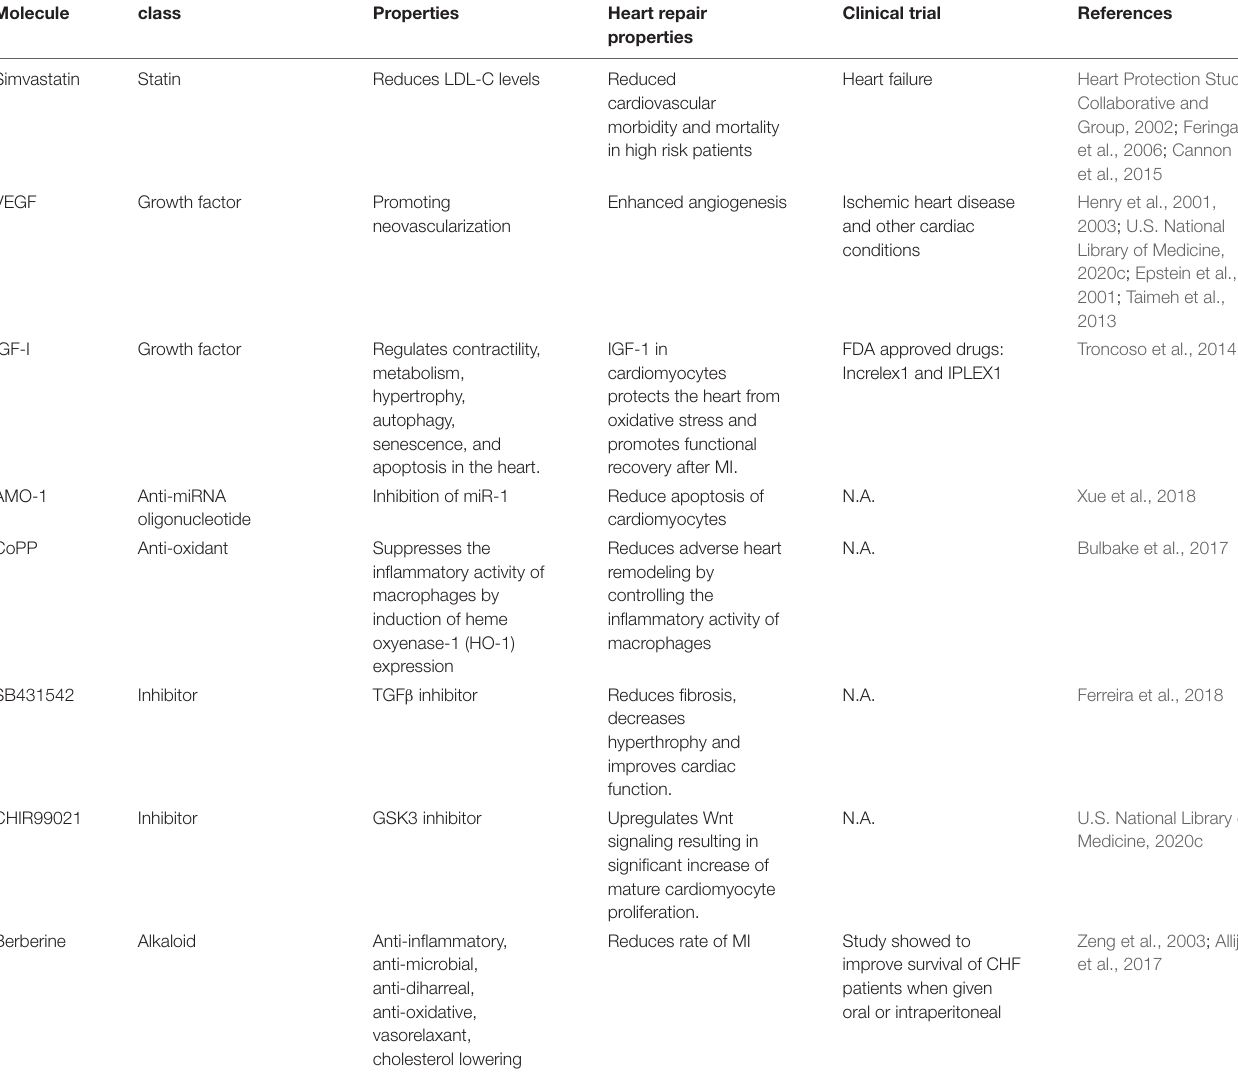
TABLE 2 | Drugs and small molecules as cardioprotective agents in nanomedicine applications.